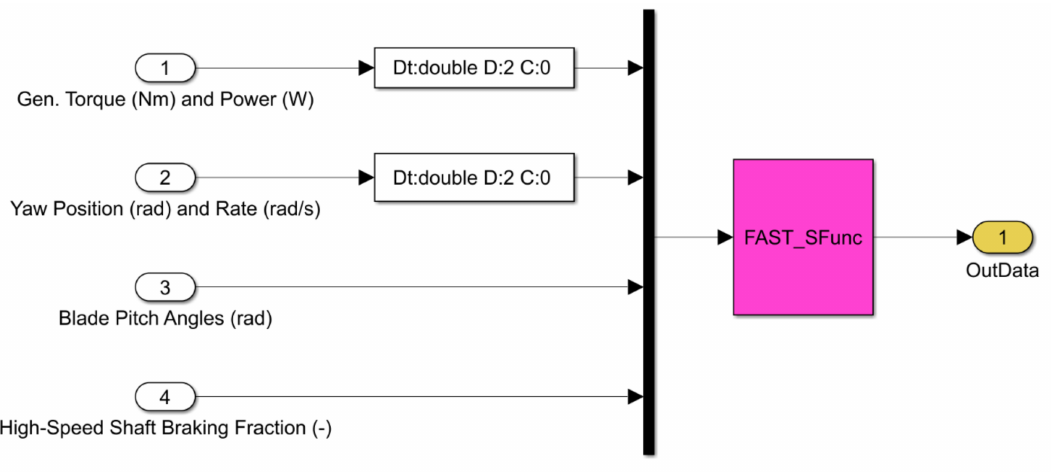
Figure 3. OpenFAST wind turbine sample model in